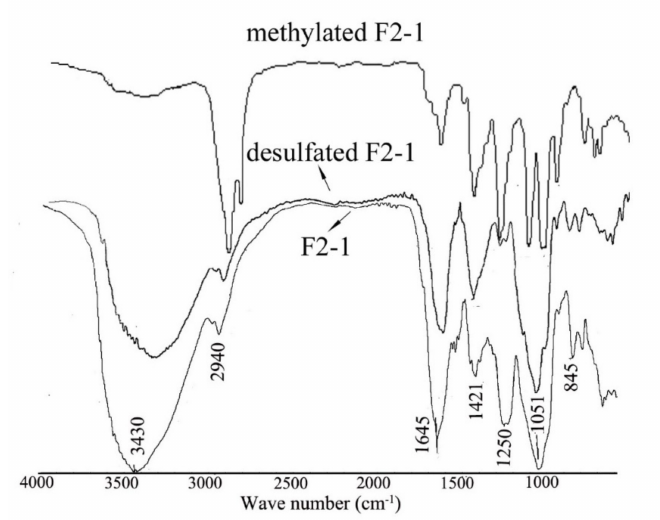
Figure 2. IR spectrum of F2-1, methylated F2-1, and desulfated